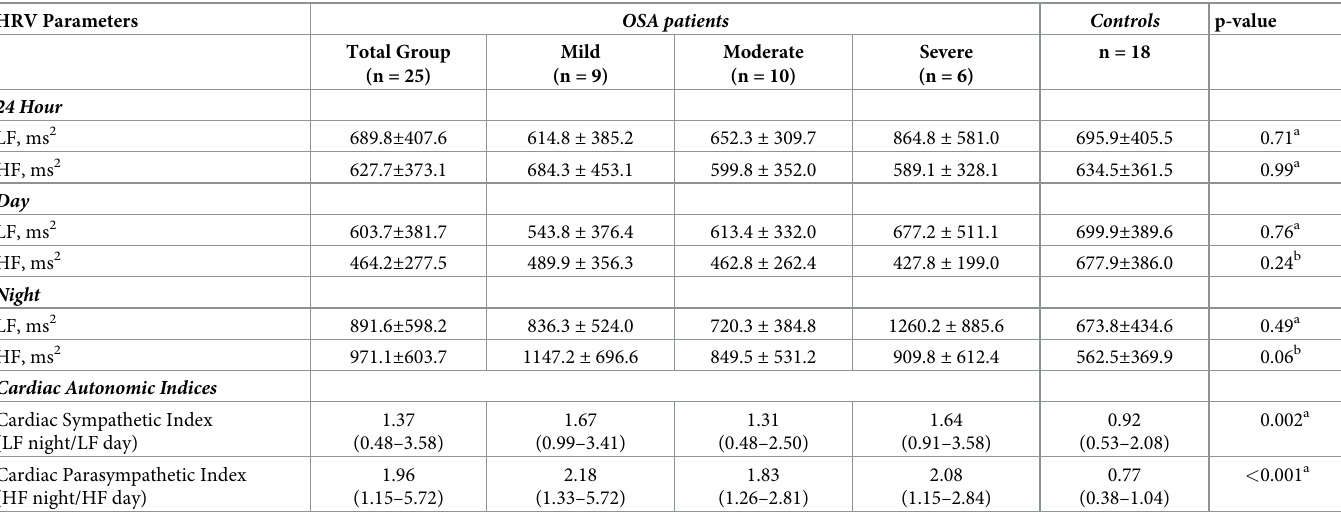
OSA: subjects with presence of Obstructive Sleep Apnea on polysomnography; Controls: subjects with absence of Obstructive Sleep Apnea on polysomnography; Data